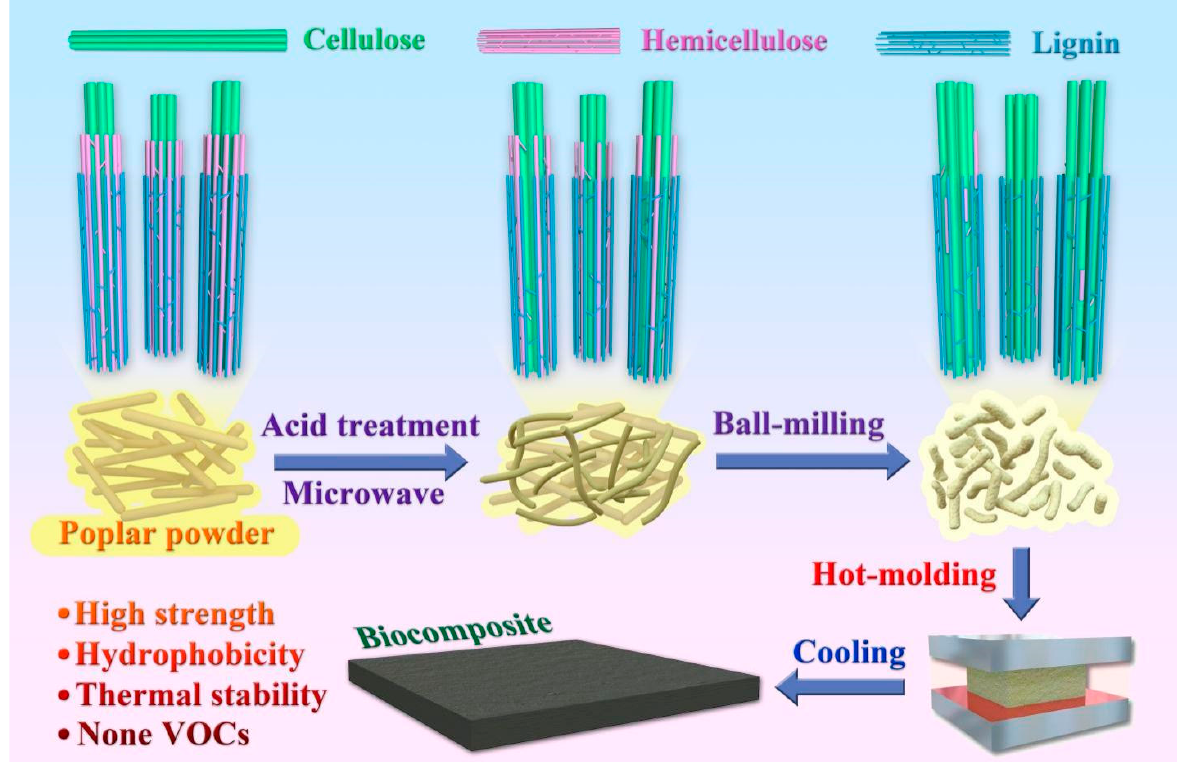
Figure 1. The production process of biocomposites from poplar via pretreatment of phosphoric acid followed by ball-milling and hot-moulding.